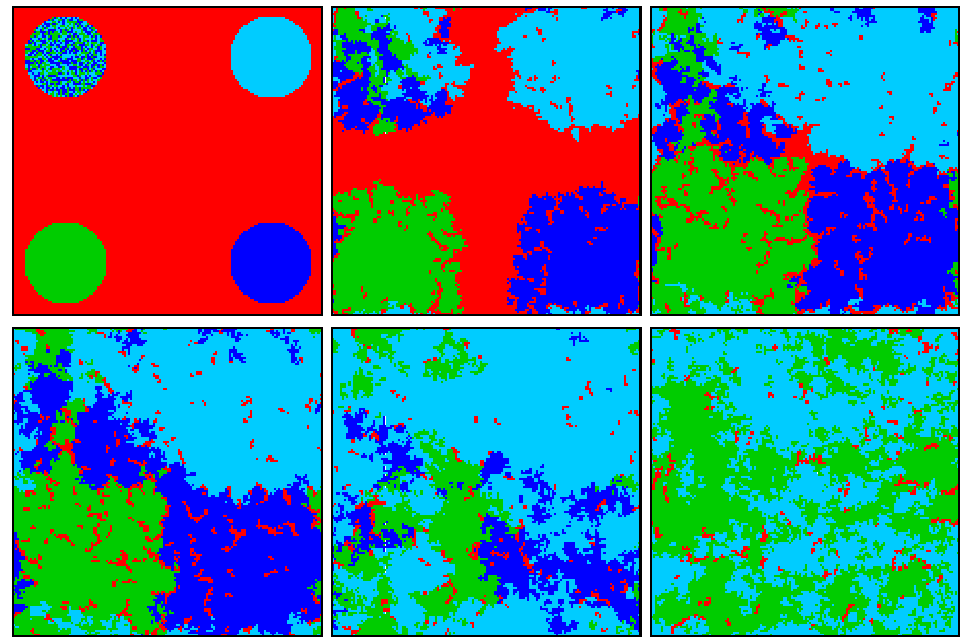
FIG. 4. Snapshots of the square lattice, showing a characteristic evolution from a prepared initial state, as obtained for (cid:2) ¼ 0 : 0015 , (cid:1) ¼ 0 : 1 , and r ¼ 4 : 5 . Strategies D , P , R , and B are depicted in red, green, dark blue, and light blue, respectively. (The same colors are used in Fig. 3.) Time runs from the top left panel toward the bottom right panel at 0, 100, 210, 300, 1130, and 8700 Monte Carlo steps, respectively. At 0 MCS, the game is initiated from a prepared initial state (the upper left domain is a mixture of strategies P , R , and B ) to allow the usage of a very small system size ( L ¼ 150 ) that still allows us to infer strategy configurations in sufficient detail. At 100 MCS, D (red) percolates slightly into green, light blue, and dark blue clusters, indicating that all three cooperative strategies could form a two-strategy phase with defectors. At 210 MCS, the borders of the three mentioned two-strategy phases ( D þ P , D þ R , and D þ B ) meet, and at 300 MCS, it can be observed that strategy B (light blue) is capable of invading into the D þ P phase while strategy R is unable to do the same. While R and B are neutral in the absence of D , in direct competition against D , strategy B is more effective and thus continues to crowd out strategy R , as can be inferred at 1130 MCS. Interestingly, strategy P has a small advantage over strategy B because strategy P can spare the cost of rewarding. Yet, this advantage is sufficient for P to survive in the bulk of strategy B . The last panel, taken at 8700 MCS, depicts a typical stationary pattern where strategies D , P , and B coexist to form the D þ P þ B